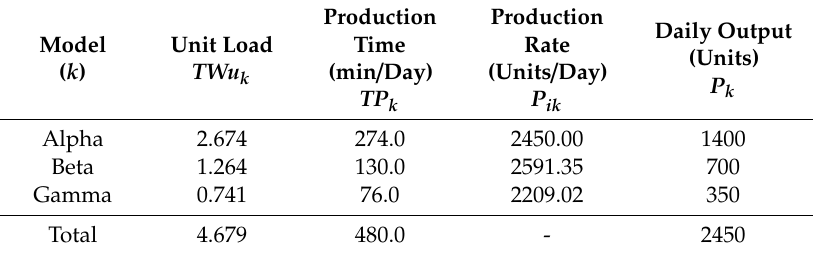
Table 8. Expected performance of the multi-model